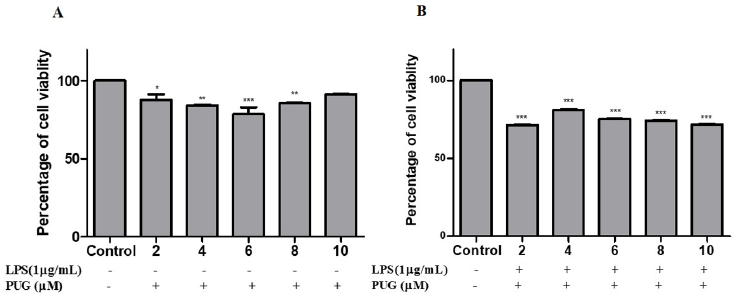
Figure 1. Cytotoxicity effect of PUG on RAW 264.7 cells. Pretreatment with or without LPS (1 μg /mL) on cells for 1 h at 37 °C. Then, cells were treated with PUG (0, 2, 4, 6, 8, and 10 μM ) for 24 h at 37 °C. ( A ) Cytotoxicity effect of PUG on non-LPS-induced RAW264.7 cells. ( B ) Cytotoxicity effect of PUG on LPS-induced cell viability in RAW264.7 cells. The data are presented as the mean ± standard error of the mean (SEM). * p < 0.05, ** p < 0.01, *** p < 0.001.